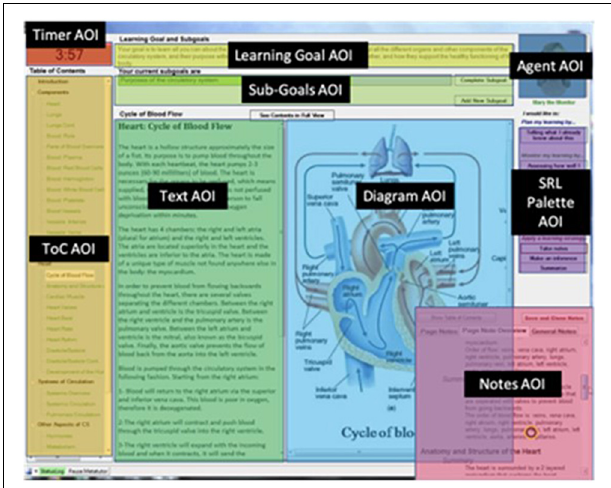
FIGURE 5 | Areas of interest on MetaTutor’s main